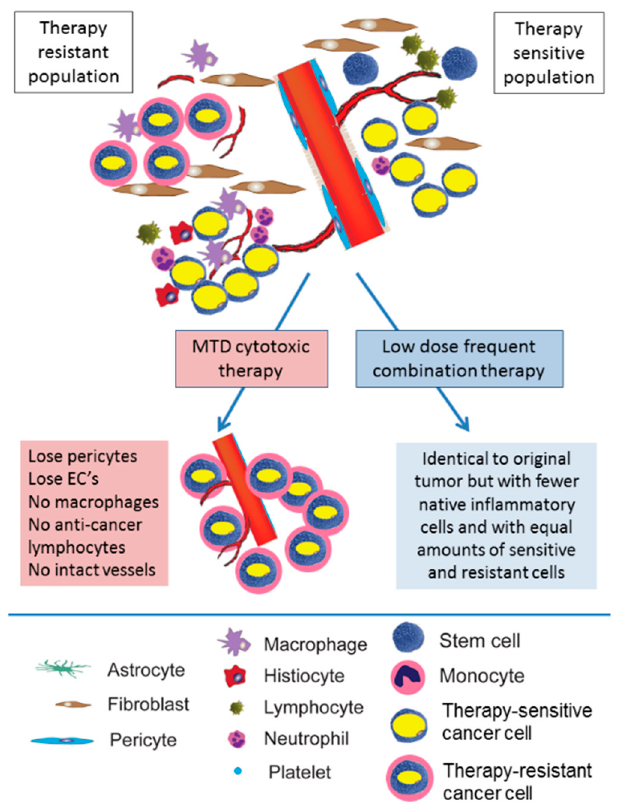
Figure 1. Comparison of the effects of maximal tolerated dose (MTD) and metronomic chemotherapy. MTD cytotoxic chemotherapy results in the ablation of anti ‐ tumor immunity and the elimination of therapy ‐ sensitive clones. In turn, these result in the selection of therapy ‐ resistant cancer cells. In contrast, low ‐ dose high ‐ frequency (metronomic) chemotherapy targets the tumor stroma, gradually reducing tumor size but mostly maintaining tumor composition, decreasing therapeutic resistance and maintaining anti ‐ tumor immunity. Figure is adapted from [26].